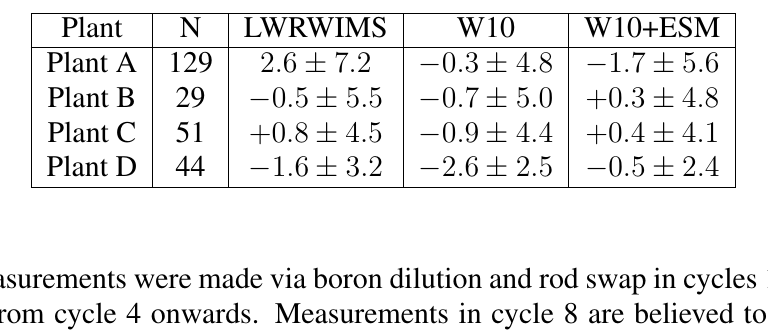
Table II: Percentage Errors in Prediction of Control Rod Bank Worth